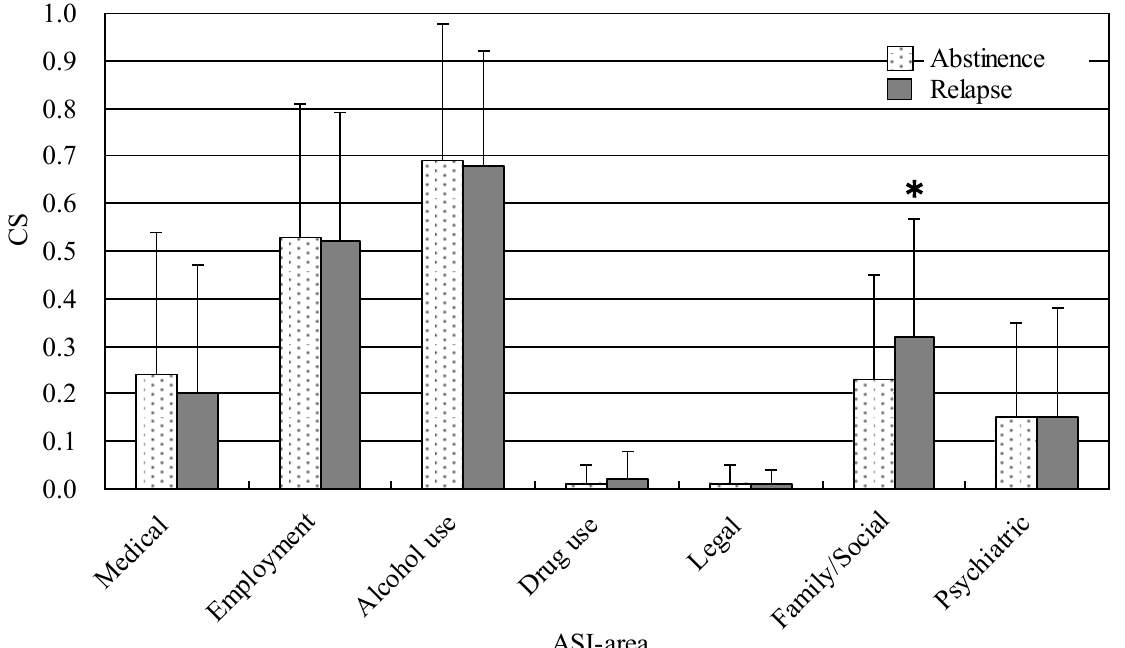
Figure 1. Comparison of CSs between abstinent and relapsed alcohol-dependent